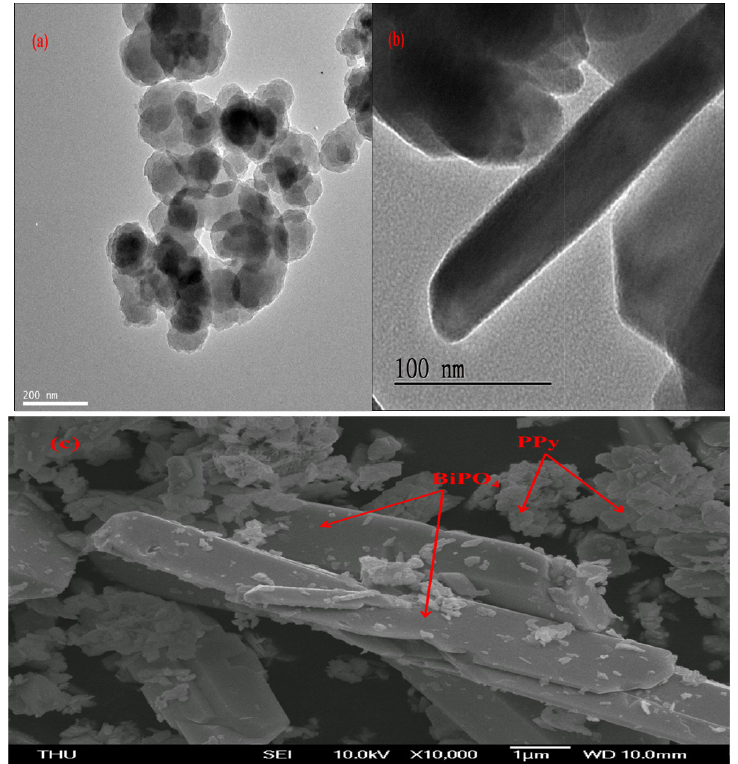
Figure 3. TEM images of ( a ) PPy, ( b ) BiPO 4 , and ( c ) FESEM 5 wt.% PPy/BiPO 4